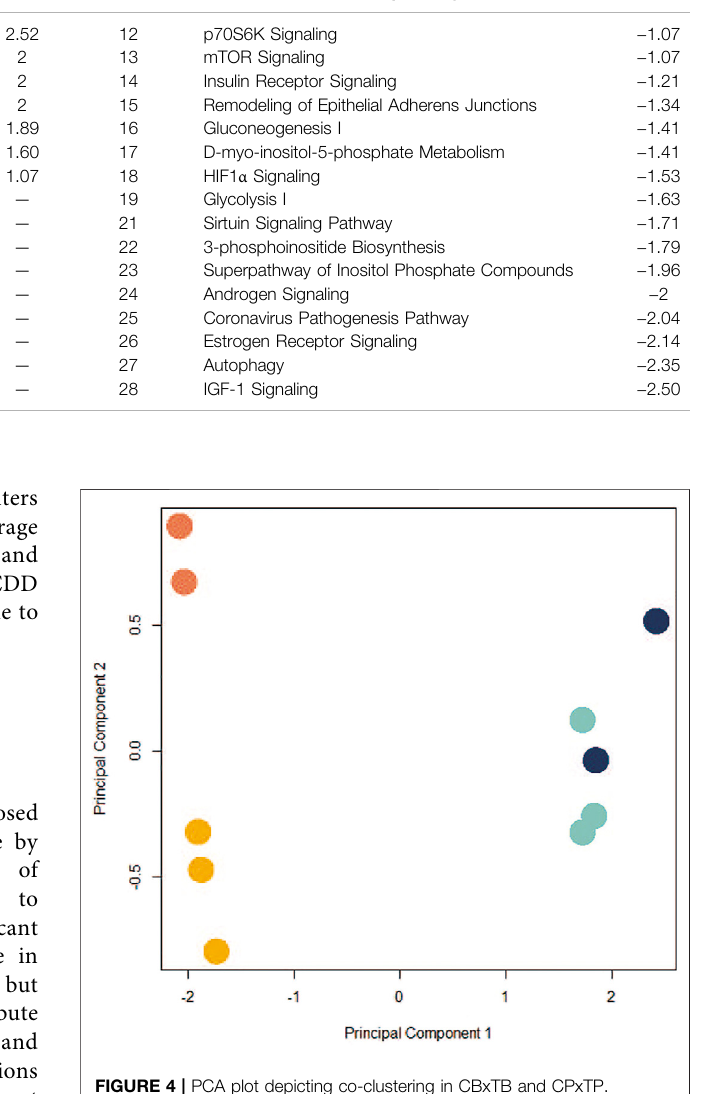
FIGURE 4 | PCA plot depicting co-clustering in CBxTB and CPxTP. Control bulk-seq (CB) replicates: light orange; TCDD-exposed bulk-seq (TB) replicates: dark orange; control pseudo bulk-seq (CP) replicates: light blue; TCDD-exposed pseudo bulk-seq (TP) replicates: dark blue. Samples clustereddistinctlyalongPC1 based onmethod ofpreparation(bulk-seq (CB, TB) or pseudo bulk-seq (CP, TP); negative and positive, respectively), independently of exposure status. Control and exposed replicates from either preparation clustered along PC2 (exposed replicates tended to cluster above the control